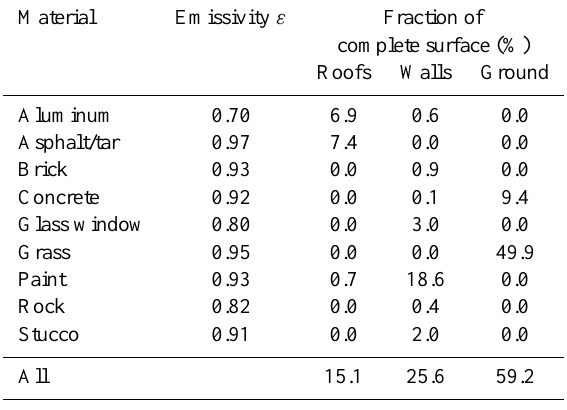
Table 1. Inventory of materials found in the Elgin Street canyon with attributed emissivities (Flir Systems, 2004), and relative fre- quency in % of complete